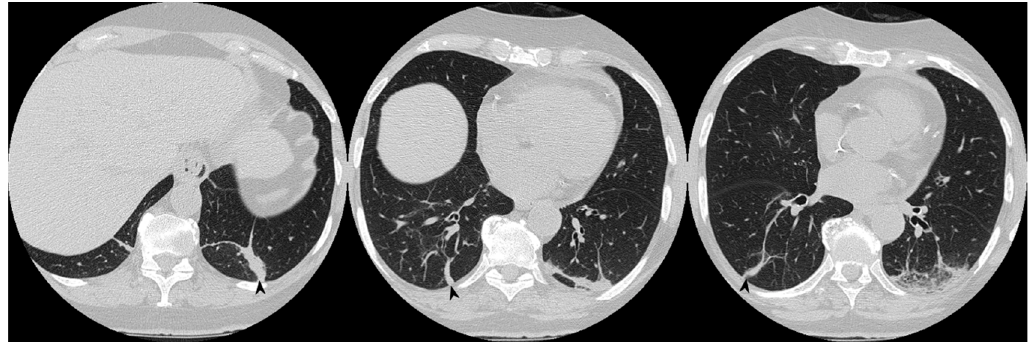
Figure 15. Persistence of band-like opacities (arrowheads) despite 13 months of steroid treatment. Table 10. Evolution of the 3 patients with linear and band-like opacities.